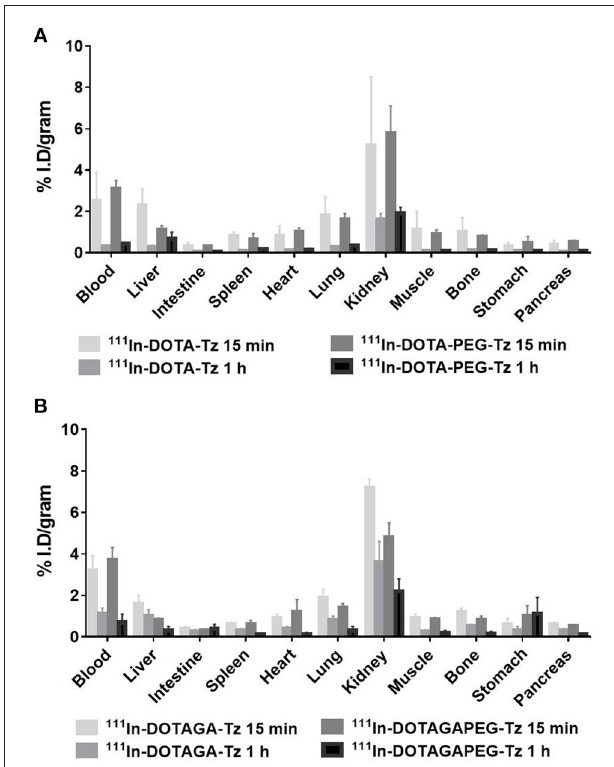
FIGURE 2 | Biodistribution data (% I.D./g ± SD) for [ 111 In]In-DOTA-Tz and [ 111 In]In-DOTA-PEG-Tz in the top image (A) and [ 111 In]In-DOTAGA-Tz and [ 111 In]In-DOTAGA-PEG-Tz in the bottom image (B) . The studies were performed in healthy mice 15min and 1h p.i. ( n = 3–5).